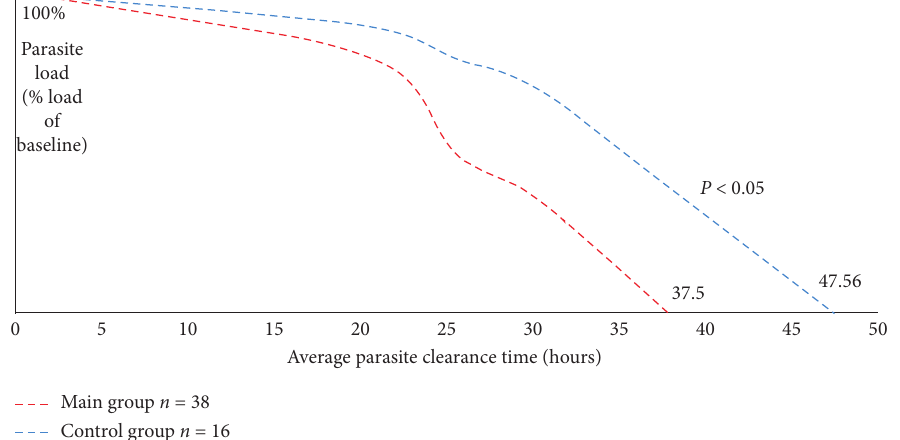
Figure 2: Parasite clearance curve according to mixed model analysis of 54 ICU patients with severe P. falciparum